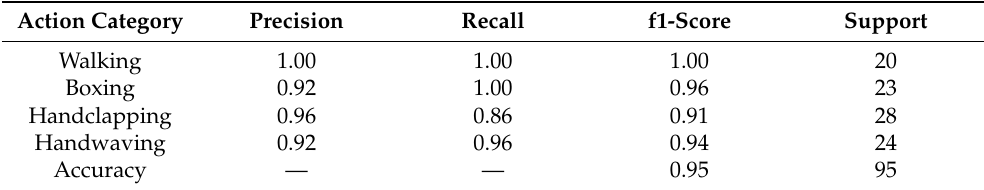
Table 7. Classification results for SC + SRN using KNN-DTW with